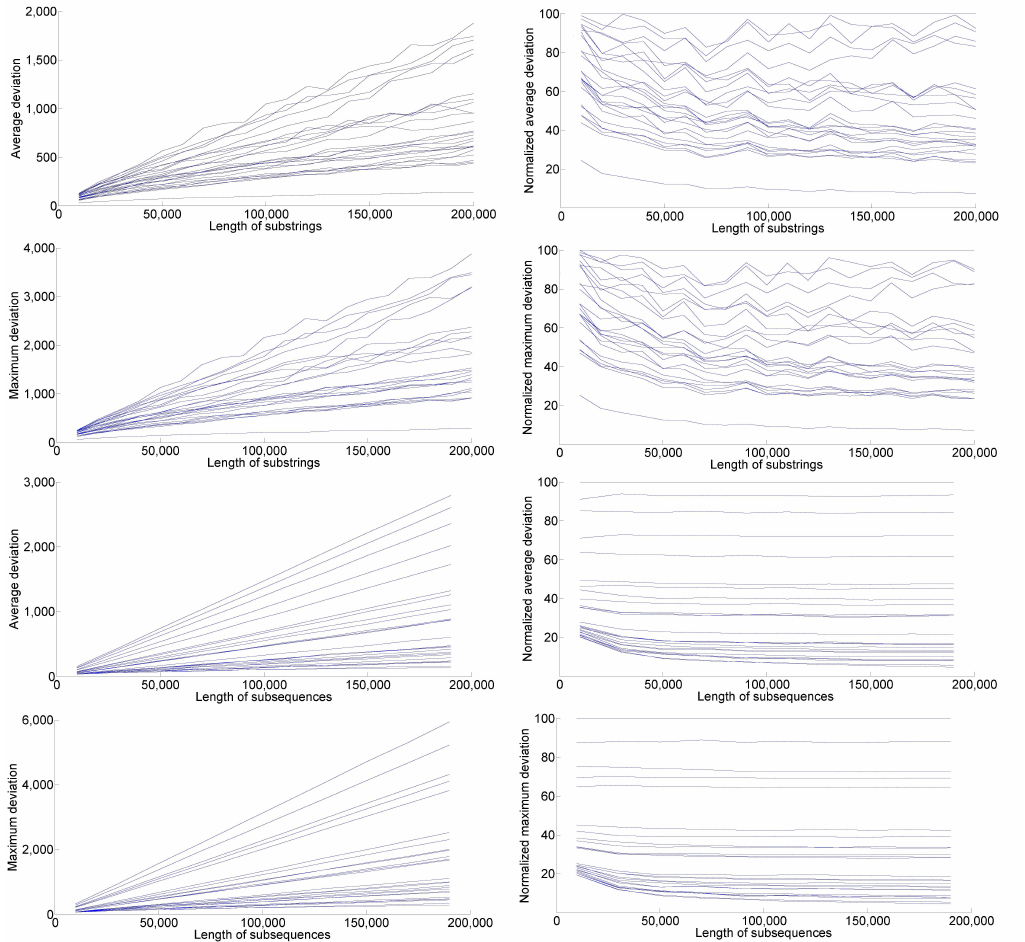
Figure 2: Absolute and normalized avd and mdv measured for substrings and subsequences of increasing length. These graphs show that adv and mdv are essentially independent of length, since the lines remain in the same relative positions as length varies. Note also that the lowest line in each graph, (which stands out noticeably when the samples are substrings) corresponds to the random